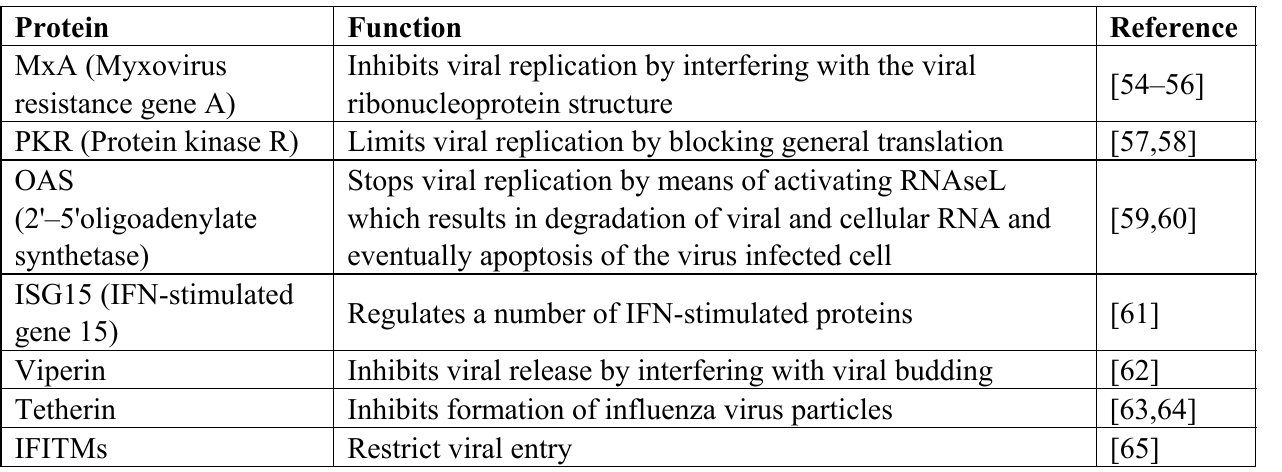
Table 1. IFN-induced antiviral proteins and their